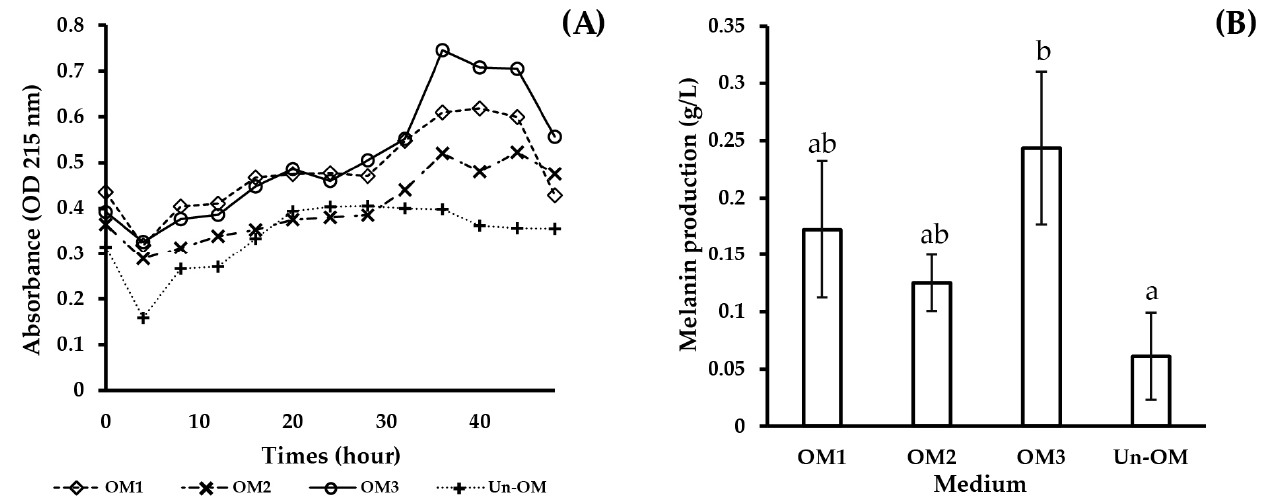
Figure 4. Production of melanin by S. antiibioticus NRRL B-1701 in a culture medium: ( A ) Optical density at 215 nm; ( B ) melanin production (g/L) at 36 h. Different lowercase letters indicate significant differences among the four culture mediums in melanin production ( p <